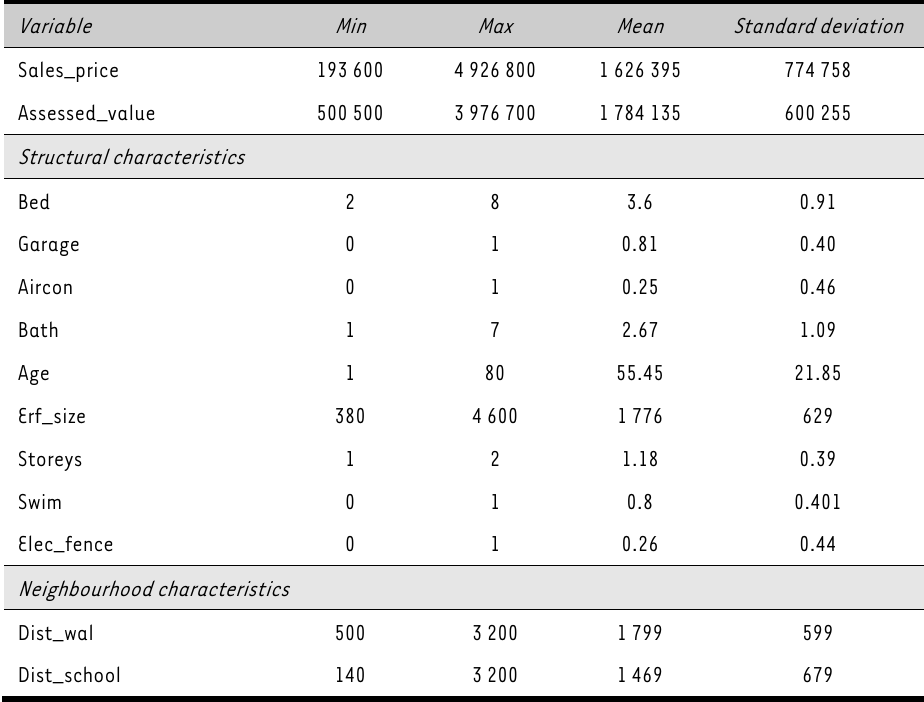
Descriptive statistics of the dependent and independent covariates used in the estimations